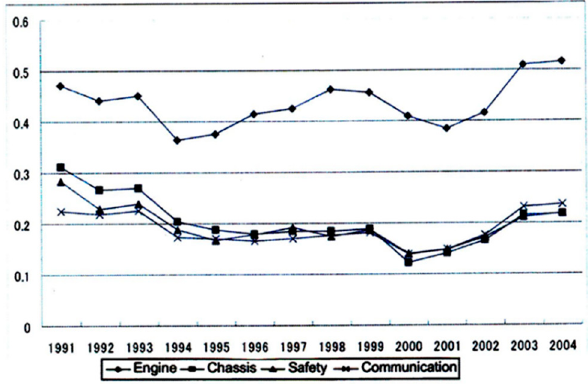
Figure 6. Changes in shares of automotive assemblers in patent application,